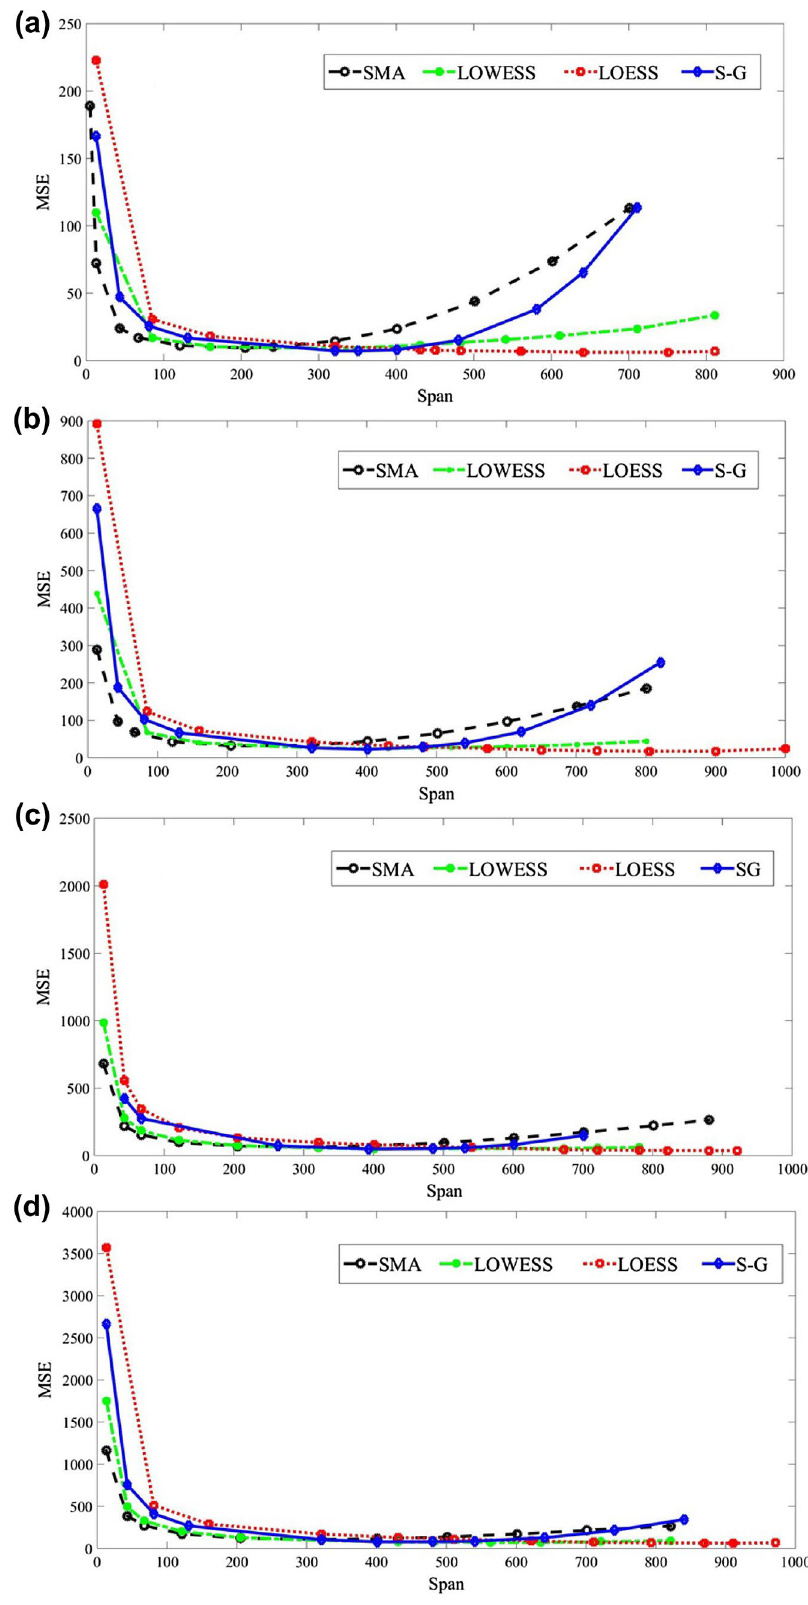
Fig. 6 MSE of various local regressive smoothers versus span for the noisy pressure signal corrupted by a 2%, b 4%, c 6%, and d 8% noise